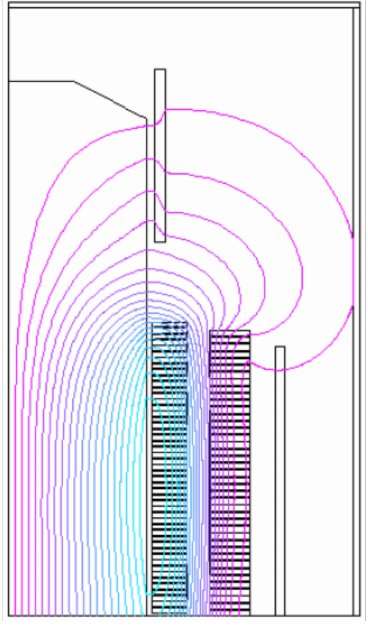
Figure 3. 40 MVA, 88/11 kV transformer field